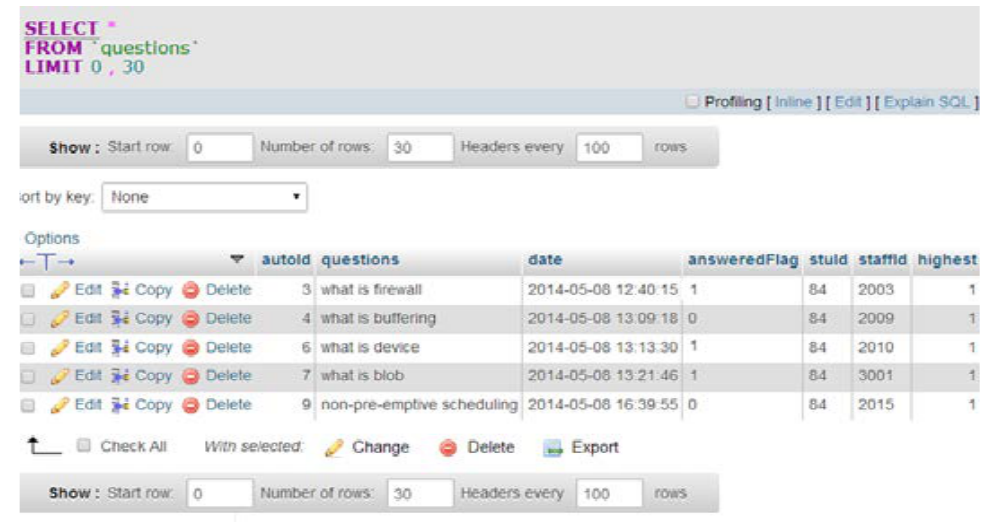
Figure 4. Question directory